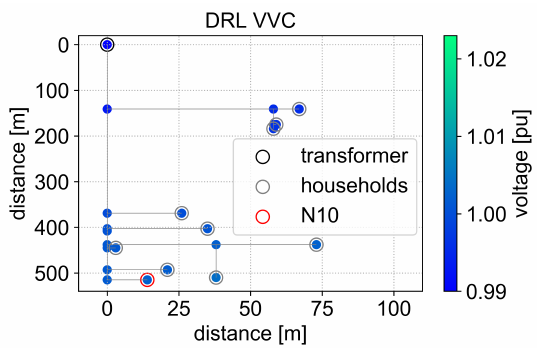
Figure 8. Voltage topology in the test feeder with reactive power injection at node N10 (red circle), the transformer is circled in black, the households in